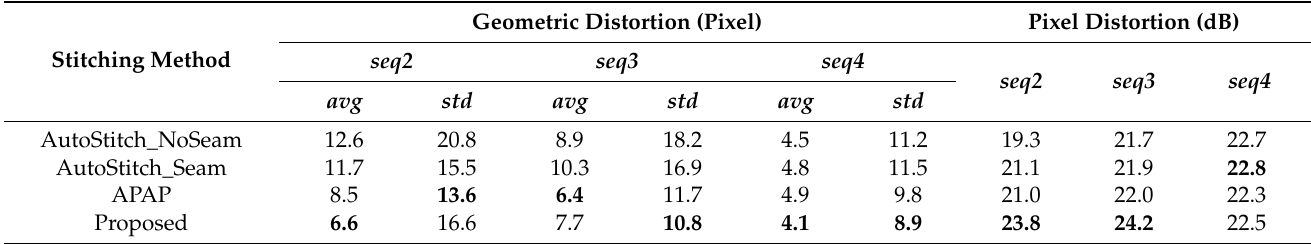
Table 1. Objective quality